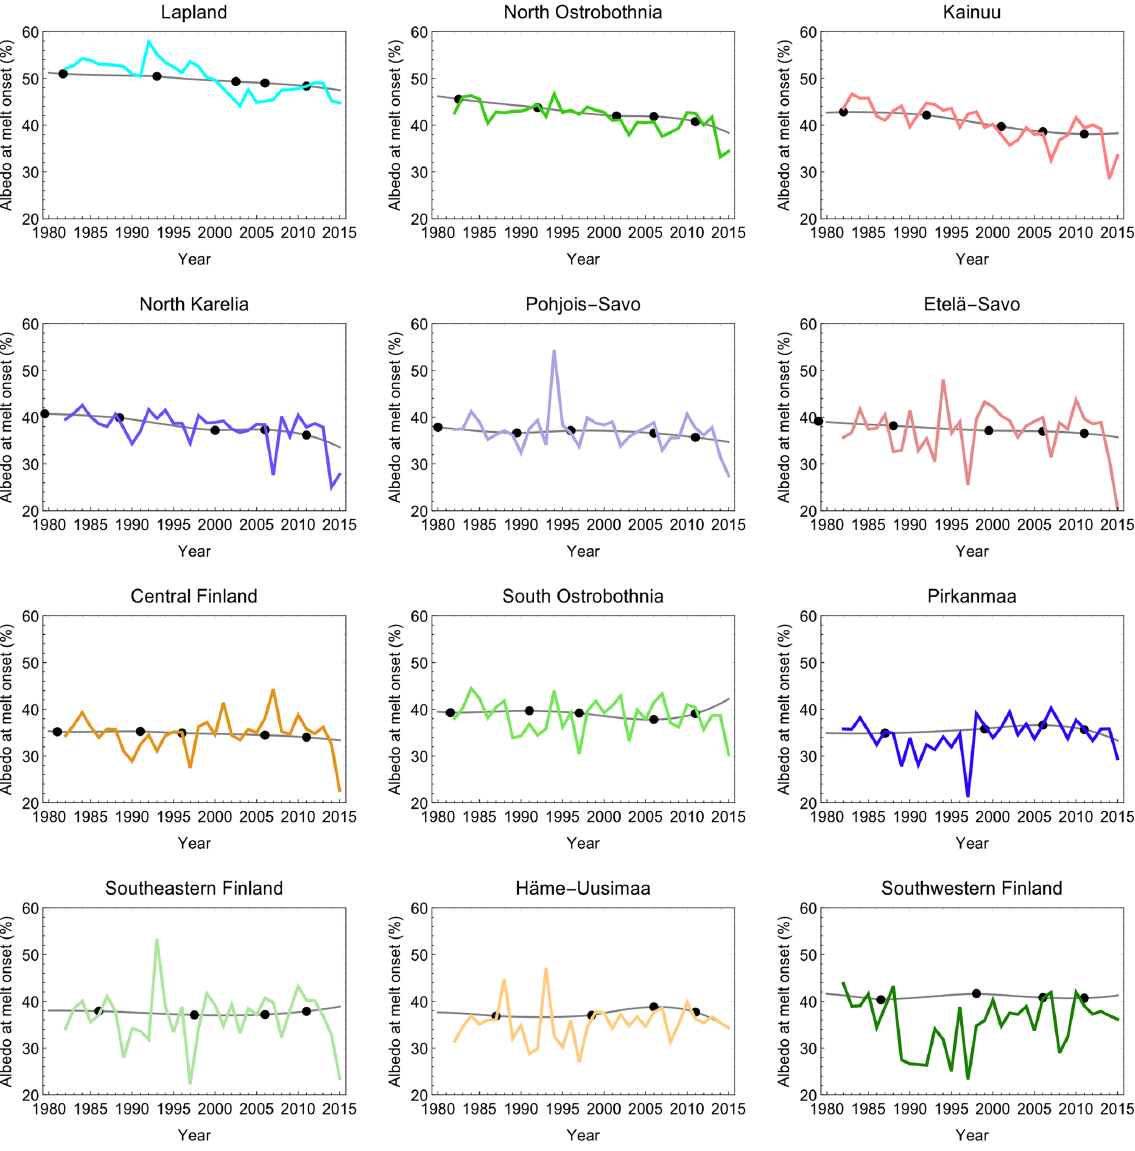
Figure 10. Comparison of observed albedo variation (colour solid curves) of the forest centre areas (Fig. 1, Table 2) during 1982–2015 and corresponding albedo model results based on stem volume measurements (points). The interpolation curves (grey solid curves) of the modelled annual values are shown as well. The colours match those of the map in Fig. 1b, except for Lapland, which is treated as one area (15 and